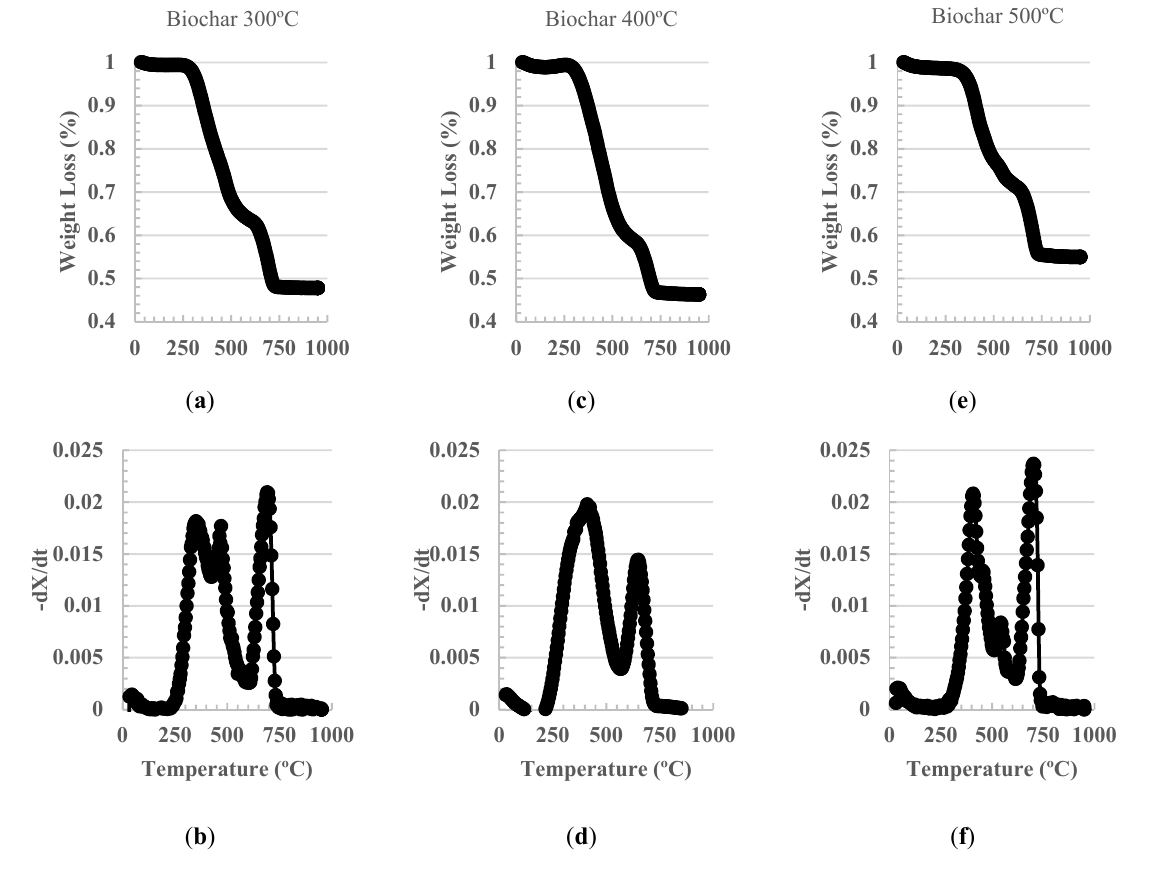
Figure 2. ( a ) TG biochar 300 °C; ( b ) DTG biochar 300 °C; ( c ) TG biochar 400 °C; ( d ) DTG biochar 400 °C; ( e ) TG biochar 500 °C; ( f ) DTG biochar 500 °C.